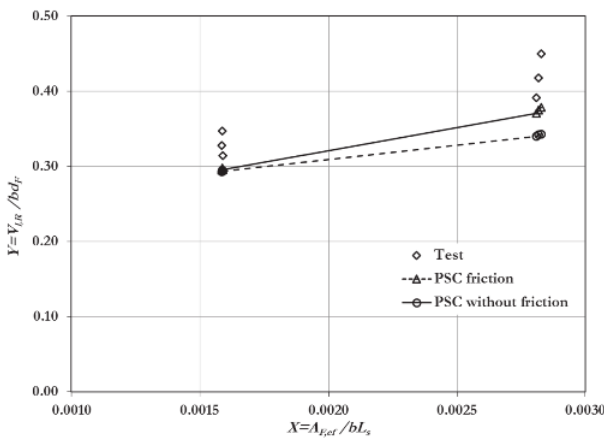
Characteristic shear resistance of specimens of the groups 03 and 04 (t = 0.95